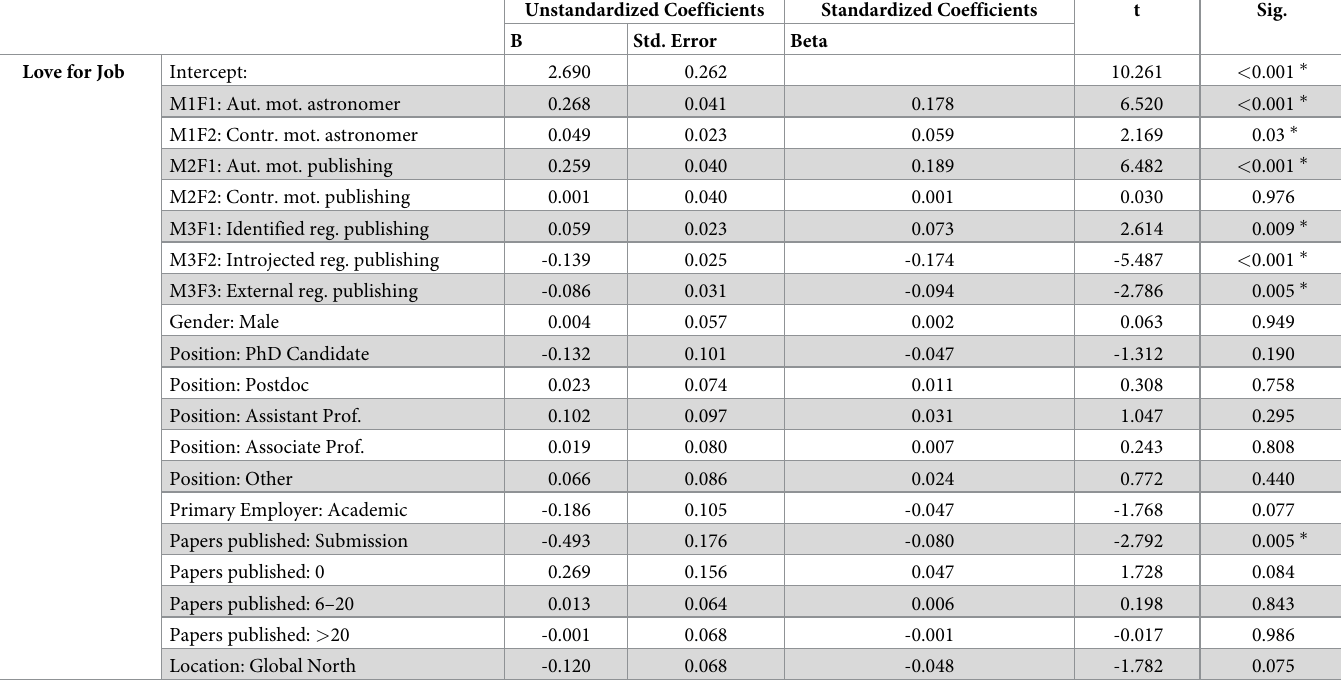
Table 5. Regression model of DV = Love for Job; regressed onto the seven motivational factors and the control